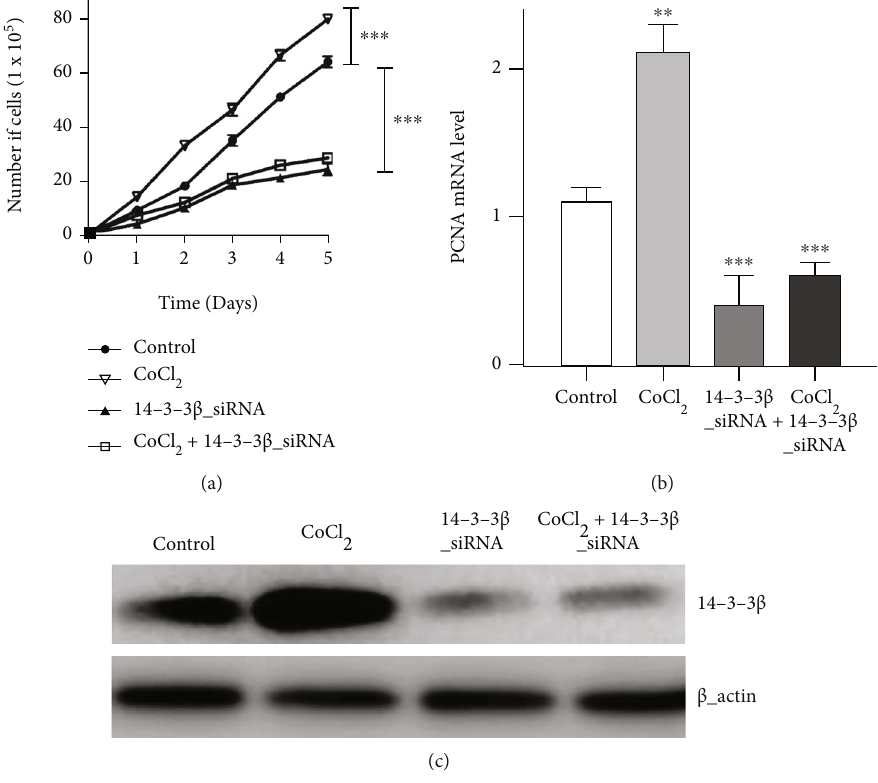
Figure 2: E ff ects on cell proliferation. (a) E ff ects of hypoxia and 14-3-3 β siRNA transfection on GSC cell proliferation assessed by MTT assay (14-3-3 β siRNA vs. control, P < 0 : 001 ; CoCl vs. control, P < 0 : 001 ). (b) E ff ects of CoCl 2 transfection on PCNA mRNA level in GSC cells (CoCl vs. control, P < 0 : 01 ; 14-3-3 β siRNA vs. control, P < 0 : 001 ; CoCl 2 , P < 0 : 001 ). (c) E ff ects of CoCl application and 14-3-3 β siRNA transfection on the PCNA protein expression in GSC siRNA vs. CoCl 2 2 cells. β -Actin was used as a loading